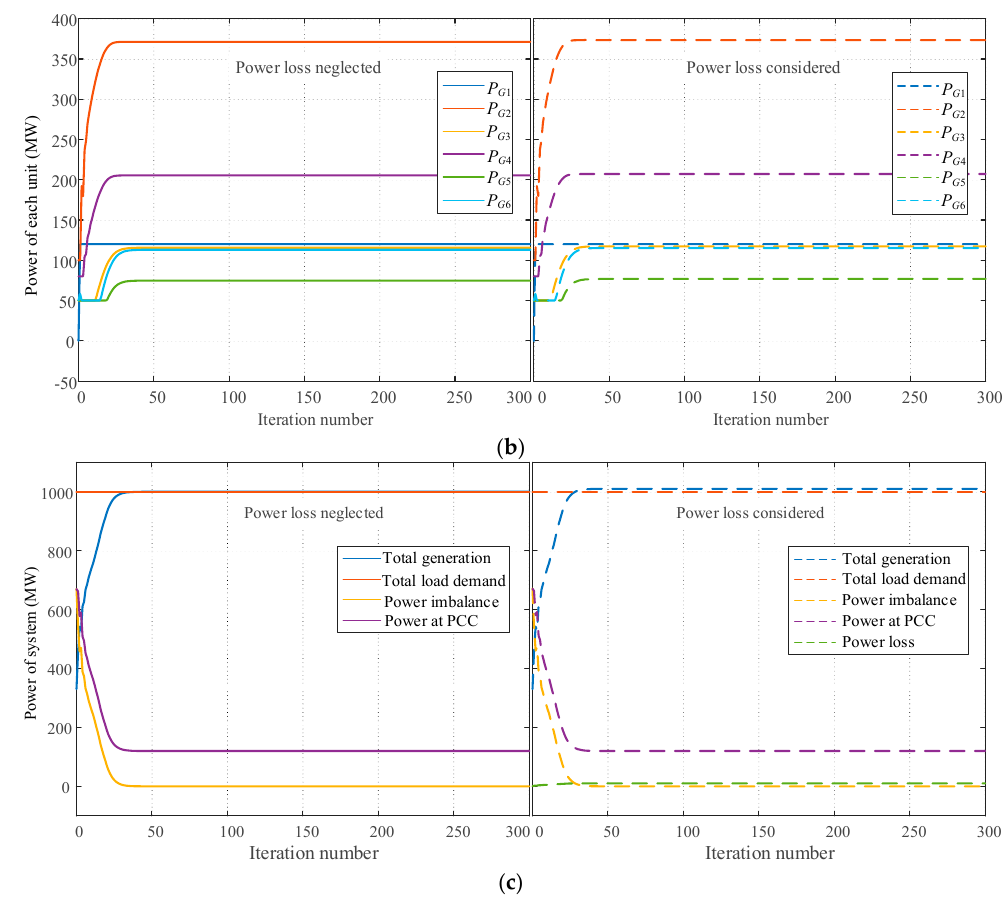
Figure 4. Simulation results of scenario 1. ( a ) incremental cost; ( b ) power of each unit; ( c ) power information of the system.